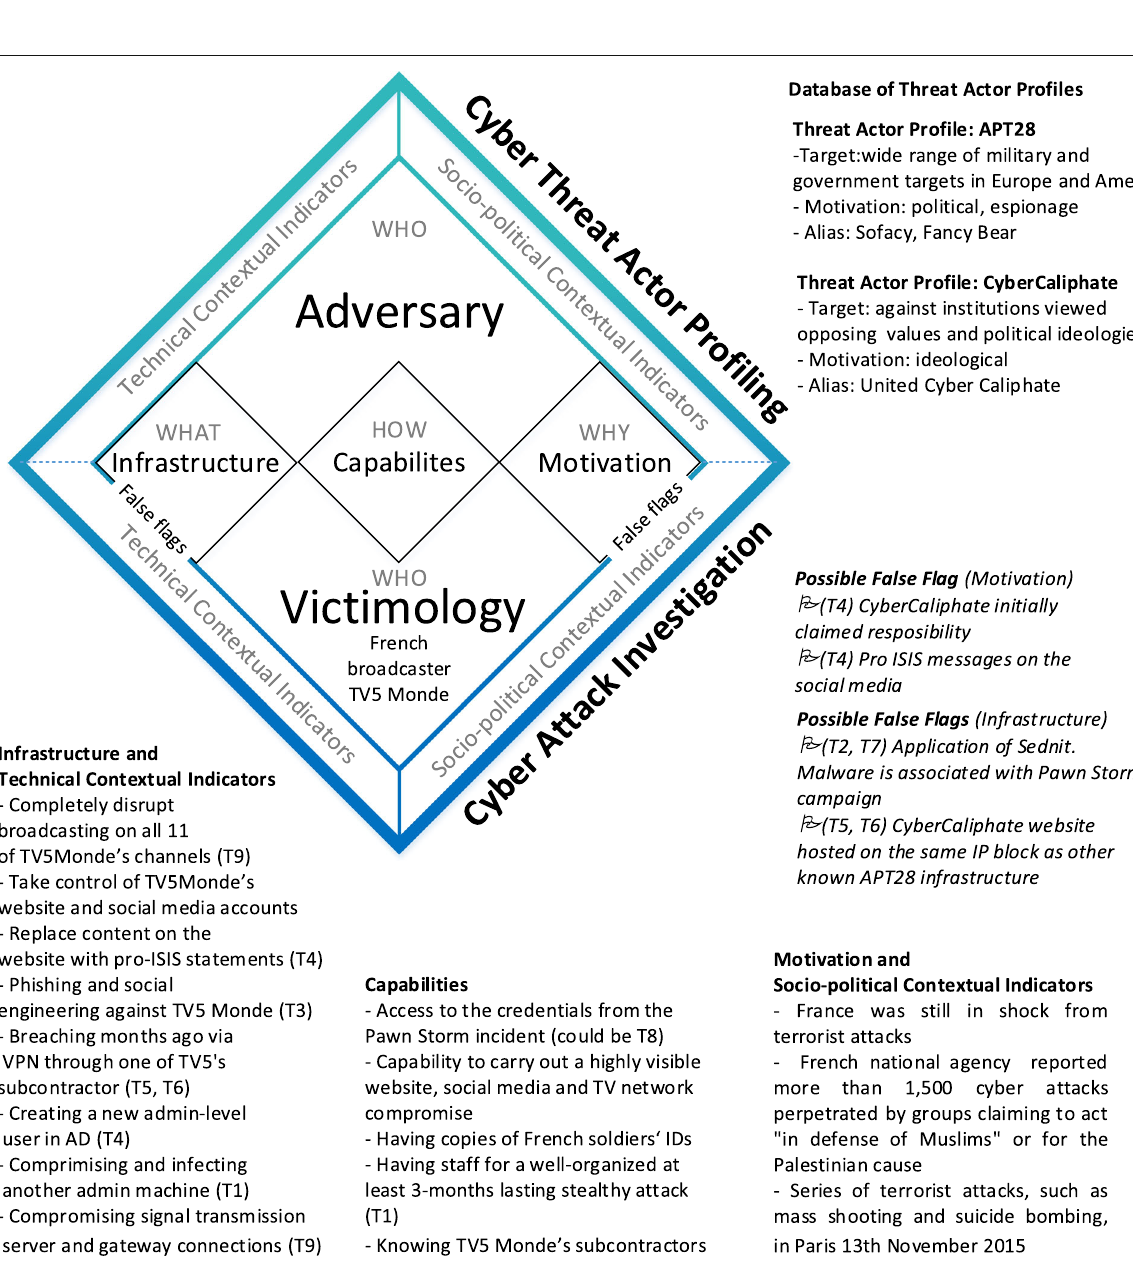
Interpretation of the results of